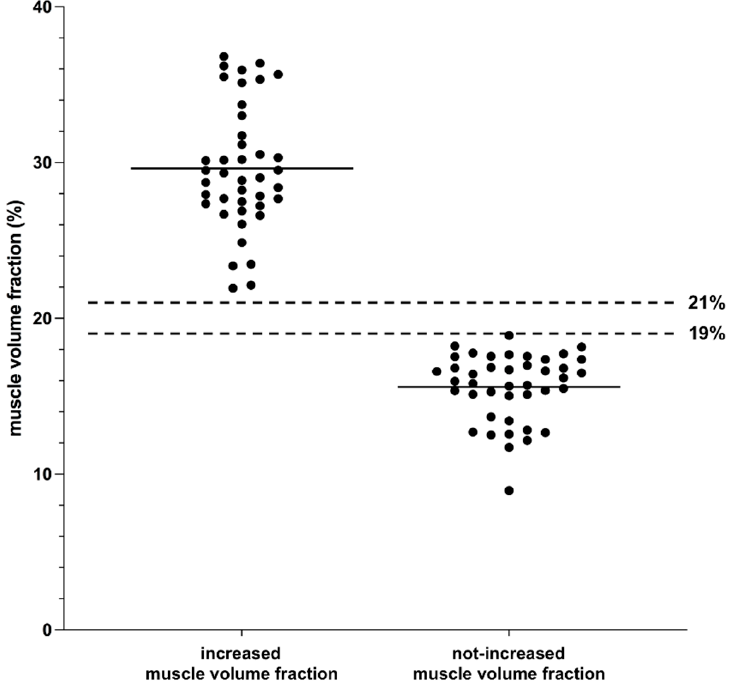
Figure 3. Volumetric analysis of orbital muscle volume fraction prior to orbital decompression. y axis: Orbital muscle volume fraction in relation to total orbital volume in %, x axis: group of orbits with an increased orbital muscle volume fraction (left, fraction ≥ 21%) and group of orbits with a not-increased orbital muscle volume fraction (right, fraction ≤ 19%), black dots: muscle volume fraction per orbit, horizontal black line: mean of values, dotted black lines: cut-off values (21% for increased muscle volume fraction and 19% for not-increased muscle volume fraction). Table 1. Classification and demographic data of the “not-increased orbital muscle volume” and the “increased orbital muscle volume” group.